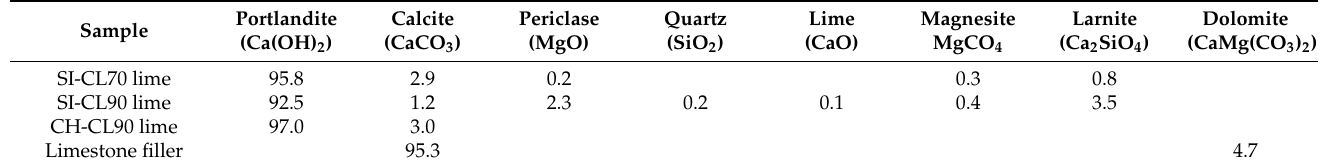
Table 2. Contents of crystalline phases in the powders, obtained by the Rietveld method.